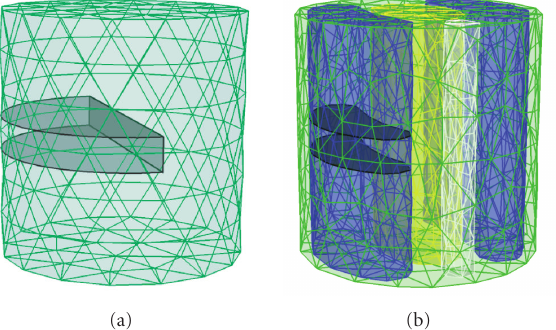
Figure 4: The initial homogeneous (a) and heterogeneous (b) fi- nite element meshes used in the BLT reconstruction. The black areas represent a priori permissible source regions. Table 2: Quantitative comparison between the reconstructed and actual sources with and without a priori anatomical and optical in- formation. Density errors are calculated by | S recons − S real | /S real . Recons. pos. Recons. dens. No.